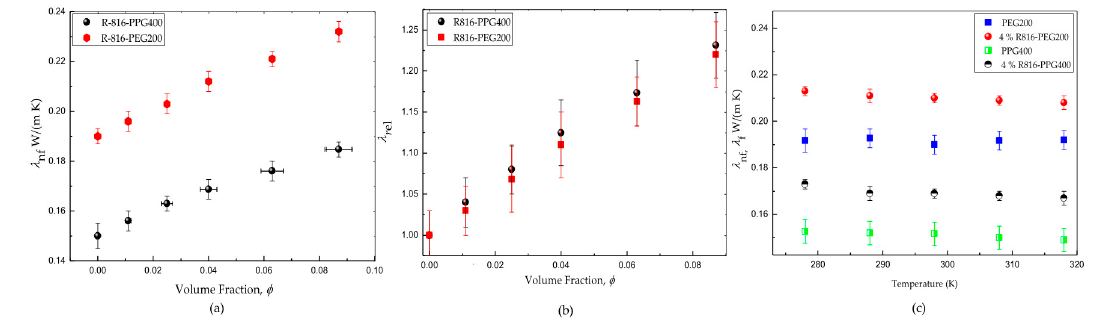
Figure 3. ( a ) Thermal conductivity of R816 fumed silica in PPG400 and PEG200 suspensions at 298 K. ( b ) Relative thermal conductivity of R816 fumed silica in PPG400 and PEG200 suspensions. ( c ) Effect of temperature on thermal conductivity of R816 fumed silica in PPG400 and PEG200 suspensions and of the base fluids.